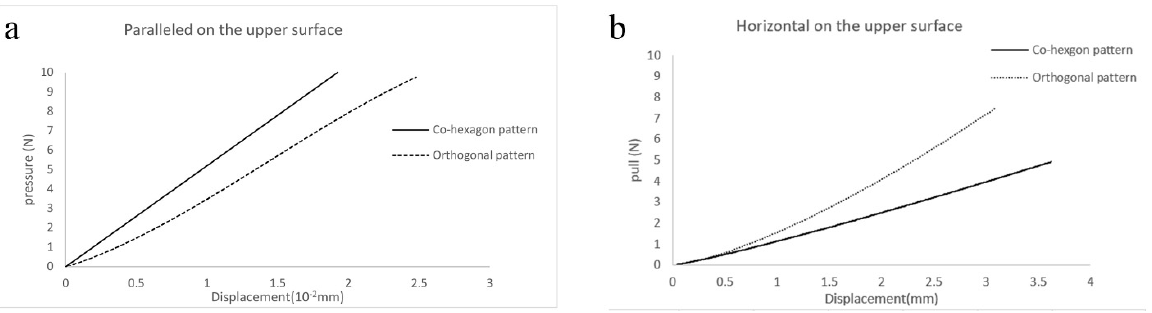
Figure 10. Printed cube model using different fill patterns ( a – c ), printed cube model ( d – f ) and microscope photographs of the printed cube model ( g – i ).